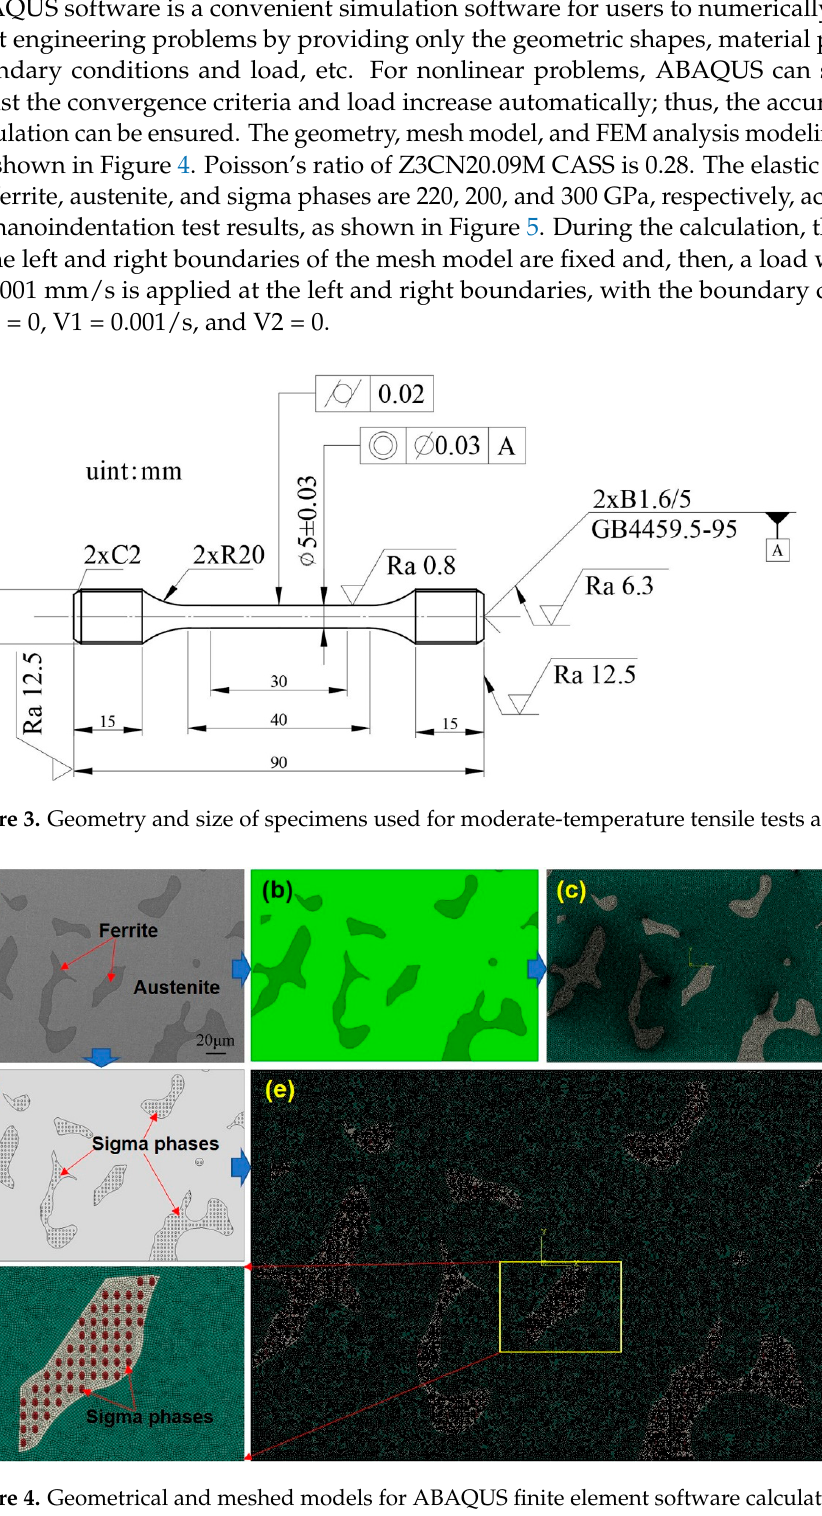
Figure 4. Geometrical and meshed models for ABAQUS finite element software calculating unaged specimens ( a – c ) without sigma phases and aged specimens with sigma phases. ( d ) model diagram of calculation; ( e ) grid division diagram; ( f ) higher magnification image of localized frame in ( e ).